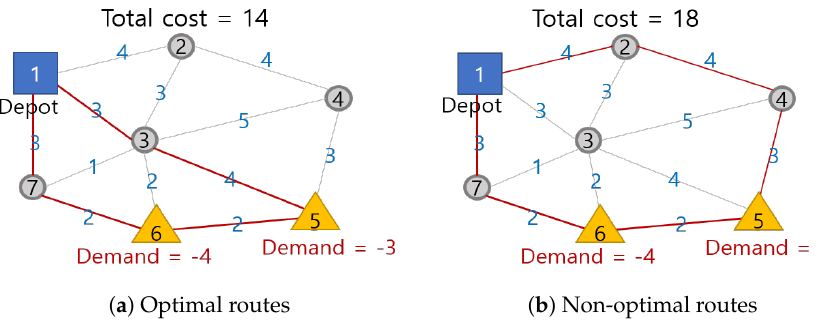
Figure 7. Optimal and non-optimal routes in a simple